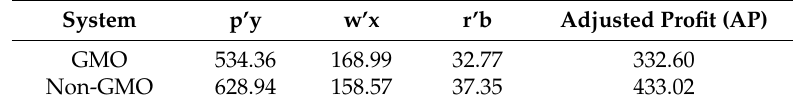
Table 9. Adjusted profit for GMO and non-GMO rice systems if the quantity for Non-GMOs is raised 10%.